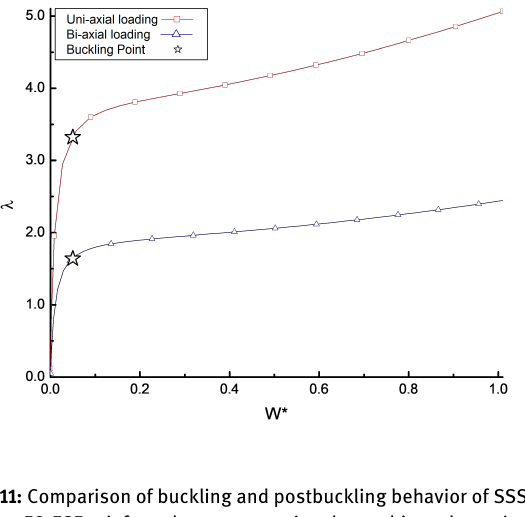
Fig. 11: Comparison of buckling and postbuckling behavior of SSSS A-type FG-ESF-reinforced nanocomposite plate subjected to uni- axial and bi-axial